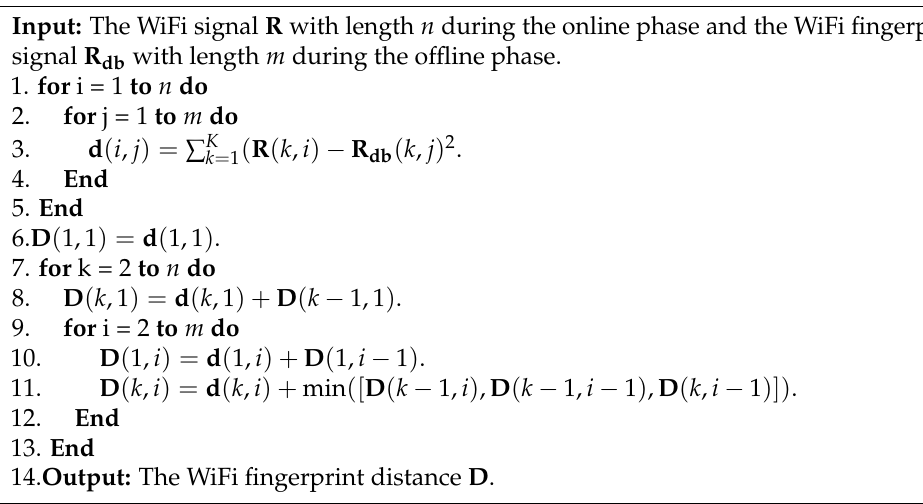
fingerprint matching algorithm uses multi-dimensional dynamic time warping algorithm, as shown in the Algorithm 1. Algorithm 1 Multi-dimensional dynamic time warping for WiFi fingerprint